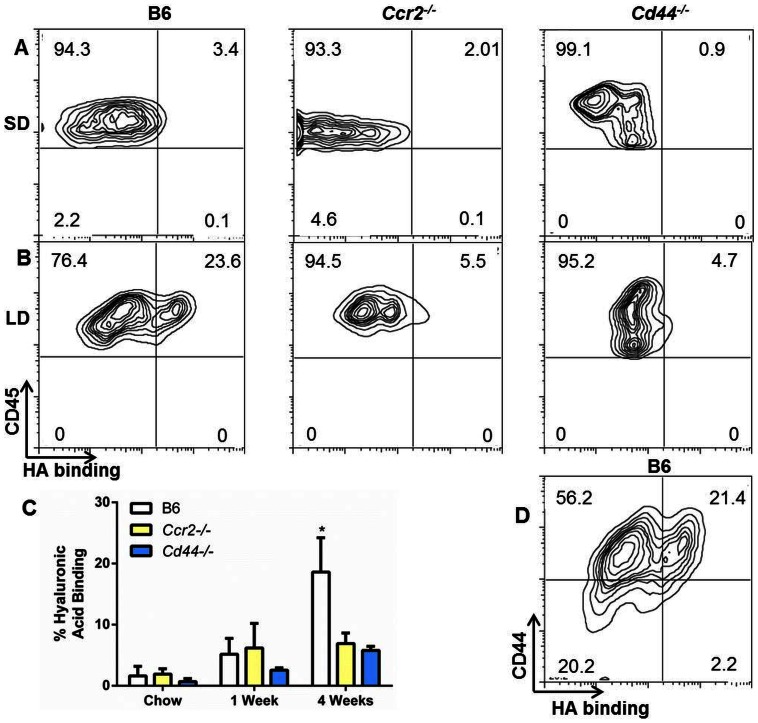
Hepatic leukocytes from B6 mice bind to hyaluronic acid in a CD44 dependent manner.(A) HA binding of CD45+ cells from a representative SD fed B6, Ccr2−/− and Cd44−/−mouse. (B) HA binding of CD45+ cells from a representative four week LD fed B6, Ccr2−/− and Cd44−/−mouse. (C) Cumulative HA binding results over time (n = 3–6 per group). (D) In CD45+ leukocytes from LD fed B6 mice, HA binding occurs on a subpopulation of CD44+ cells.